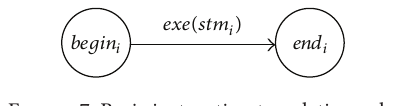
Figure 7: Basic instruction translation rule.